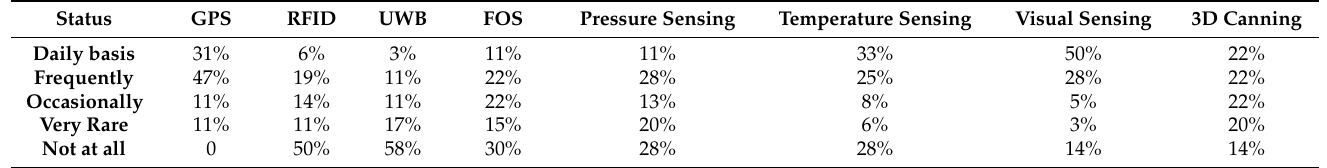
Table 4. Current status of various sensing technologies in industrial